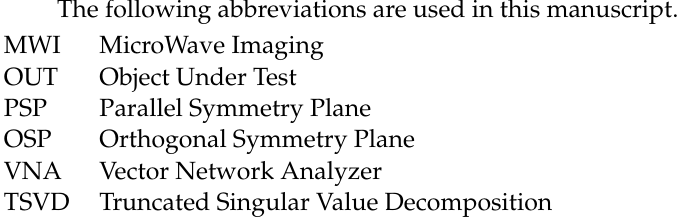
Figure A1a: two identical current distributions, J 1 and J 2 , located at mirror position with respect to the y -axis (representing the two antennas in our system), radiating in an inho- mogeneous background medium (BM), symmetric with respect to the y -axis (representing the OUT in our system), i.e., such that ε b (x, y, z) = ε b (x, − y, z), being ε b the relative